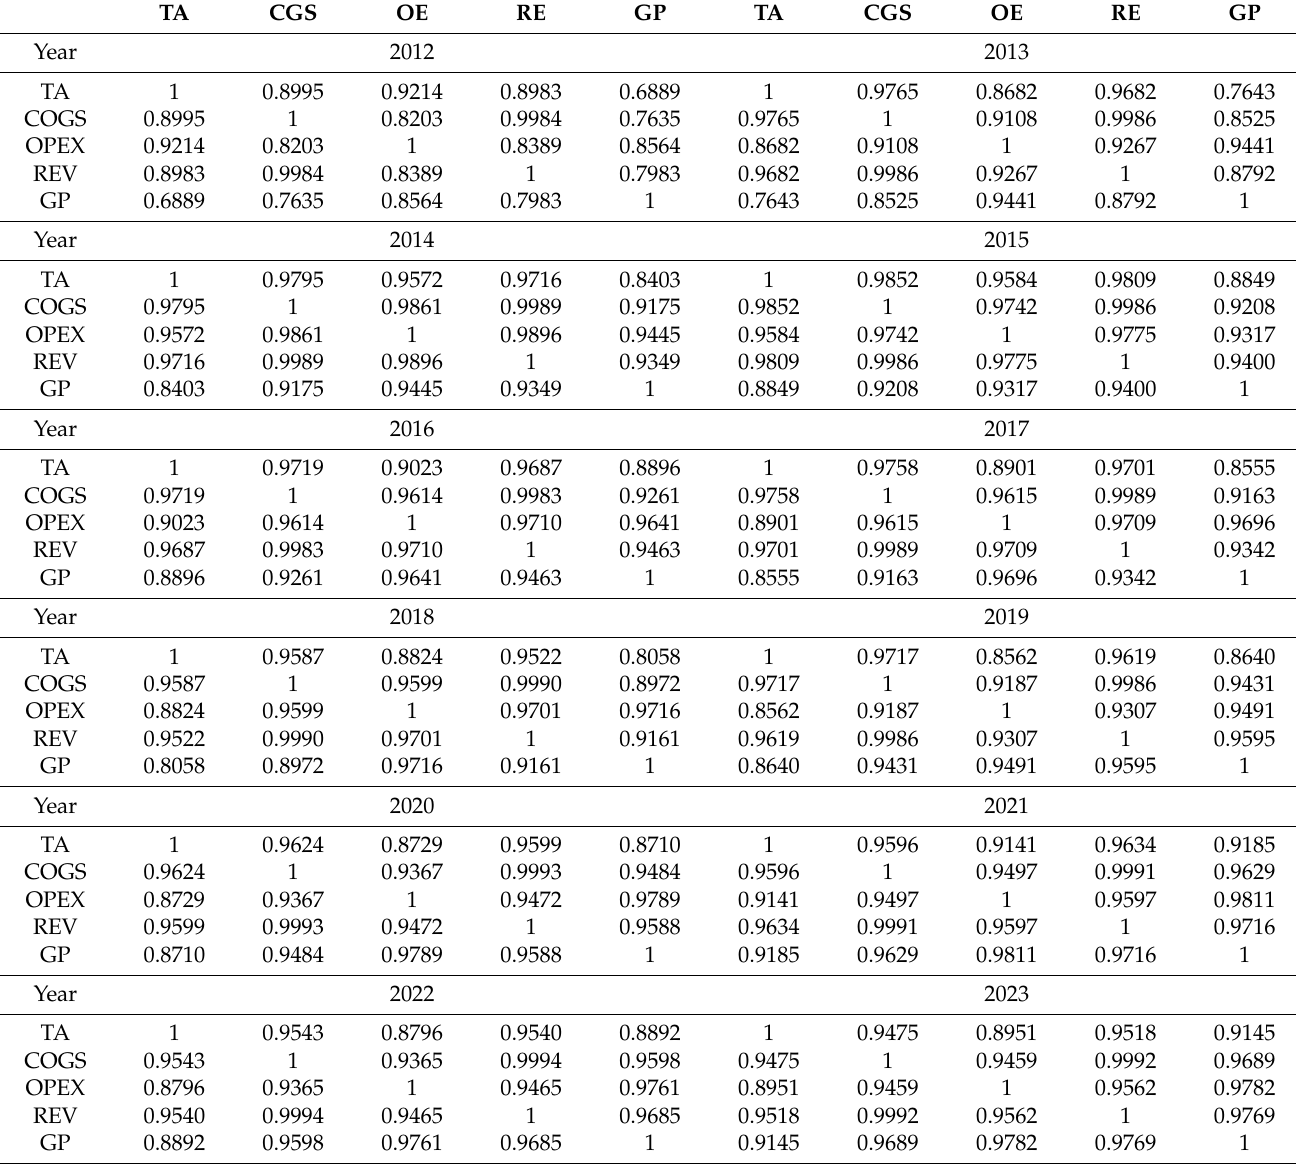
Table A4. Pearson’s correlation coefficient from 2012 to